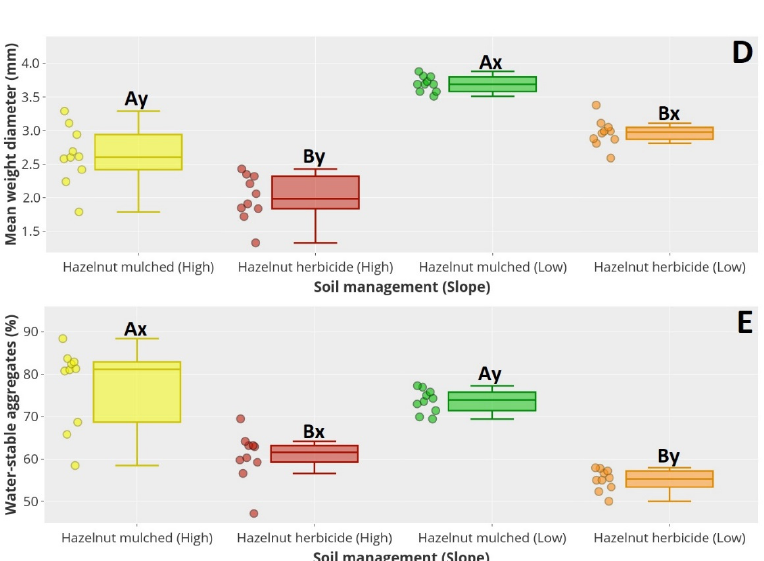
Figure 3. ( A ) Bulk density (BD), ( B ) water holding capacity (WHC), ( C ) soil water content (SWC), ( D ) mean weight diameter (MWD), and ( E ) water-stable aggregates (WSA) distribution according to the soil managements and slopes. Upper hanging bar (high edge), lower hanging bar (low edge), upper box line (third quartile), line (median), and lower box line (first quartile). Different uppercase letters (A, B) represent significant differences between soil managements ( p < 0.05). Different lowercase letters (x, y) represent significant differences between slopes ( p < 0.05).